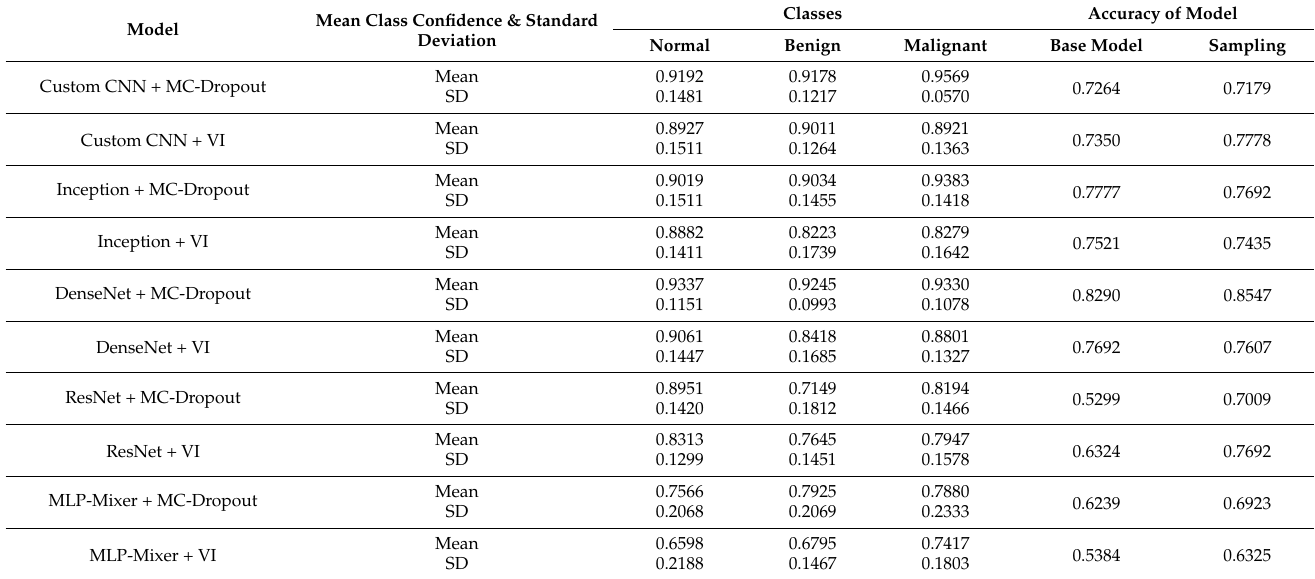
Table 2. Results of uncertainty quantification for different deep learning models used for the breast cancer